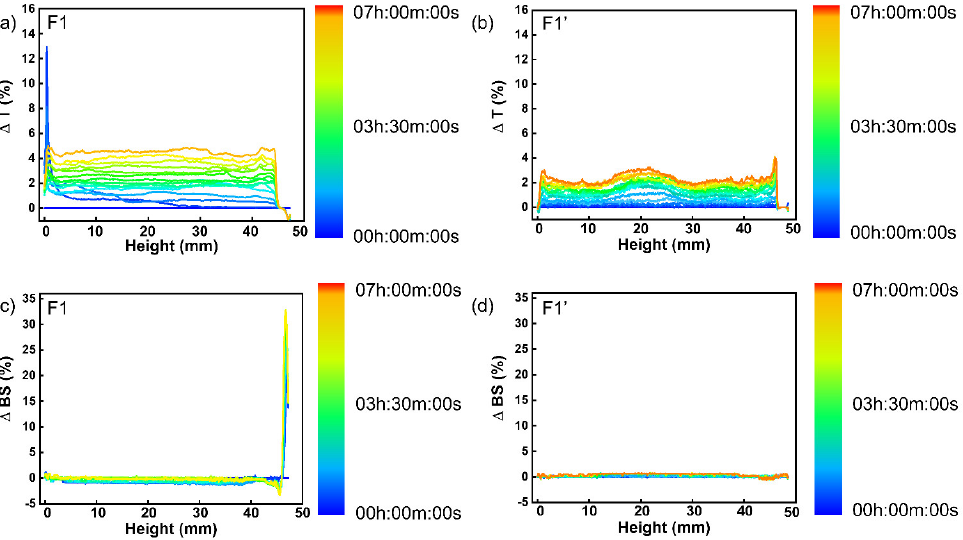
Figure 6. Turbiscan profiles of ( a , b ) transmission, and ( c , d ) backscattering, for F1 and F1′ over 7